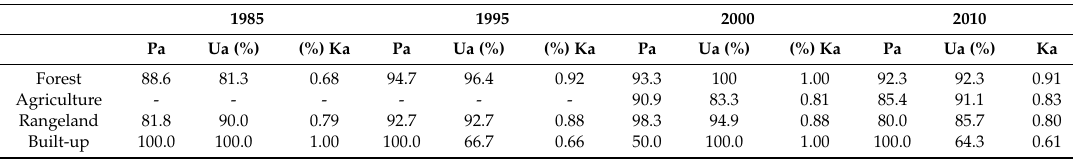
Table 4. Accuracy assessment result of classified images.